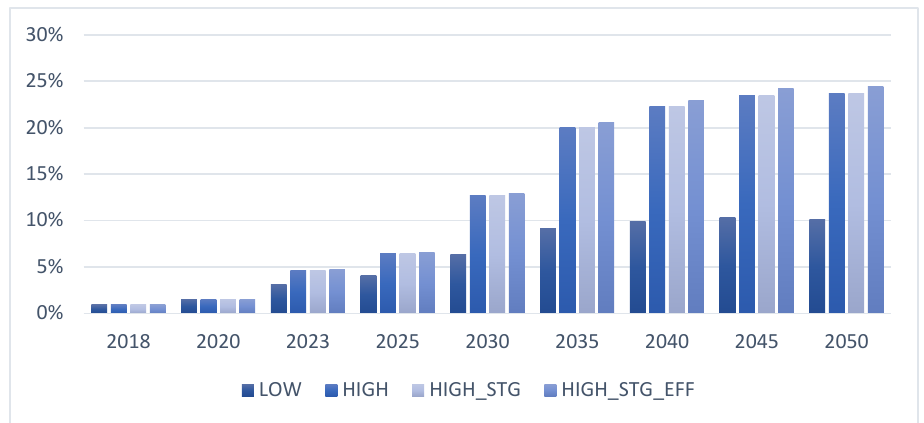
Figure 9. Renewables share in end-use electricity consumption for different scenarios.